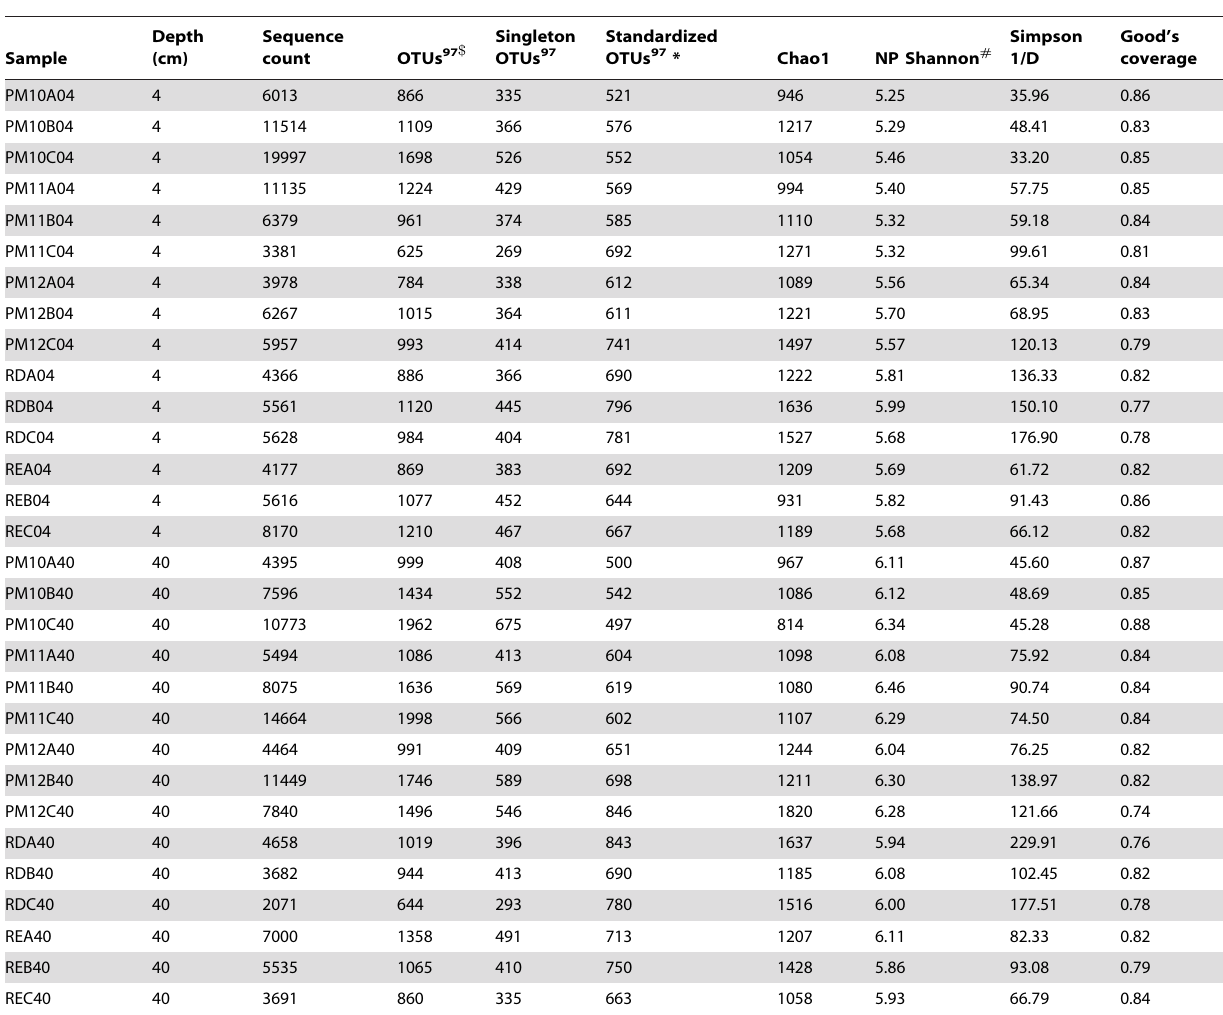
Table 3. Diversity estimators for the Oslofjord sediment samples after removal of unique sequences.